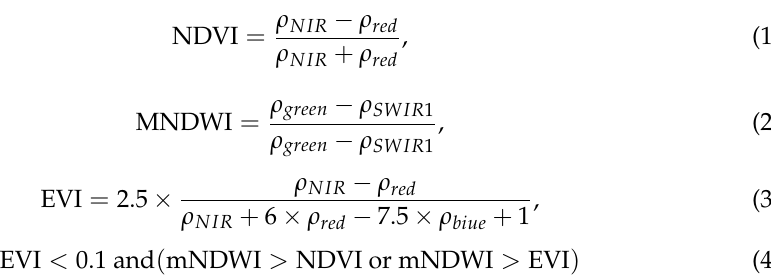
Figure 3. Interannual variation in the area ratio of the frequency with different levels of clear Landsat observations in the YRB.